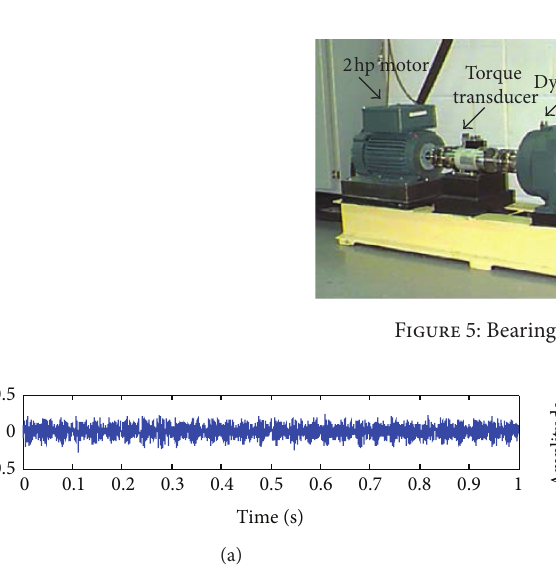
Figure 4: Flowchart of the rolling bearing fault diagnosis scheme.